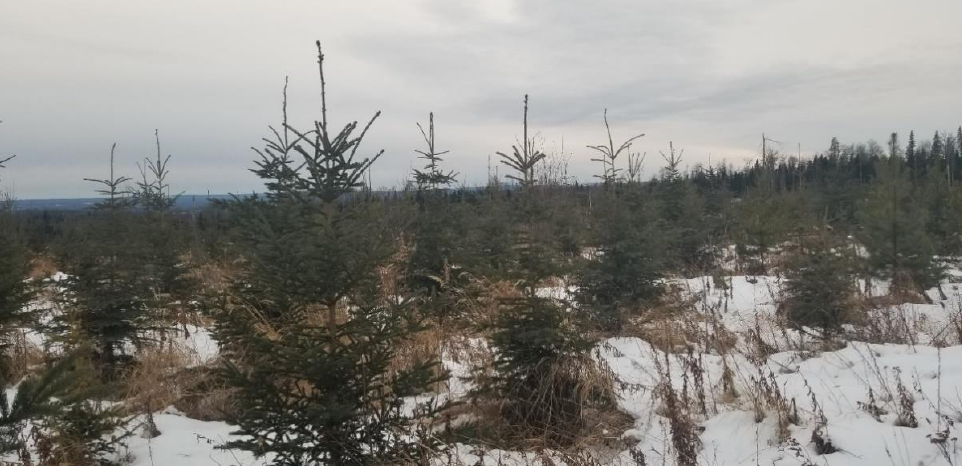
Figure 1. Example of an intensively managed, 7-year-old spruce plantation in Alberta. This stand was planted at 1800 stems per ha with improved white spruce stock, had an herbicide application at age 2, is expected to have a commercial thinning of 500 stems at age 35 and will be ready for final felling at age 50. Photo by Brad Pinno. At the stand level, the potential for intensive silviculture is clear, at least for some growing sites. In comparison to the standard basic silviculture scenario, intensive silvicul-